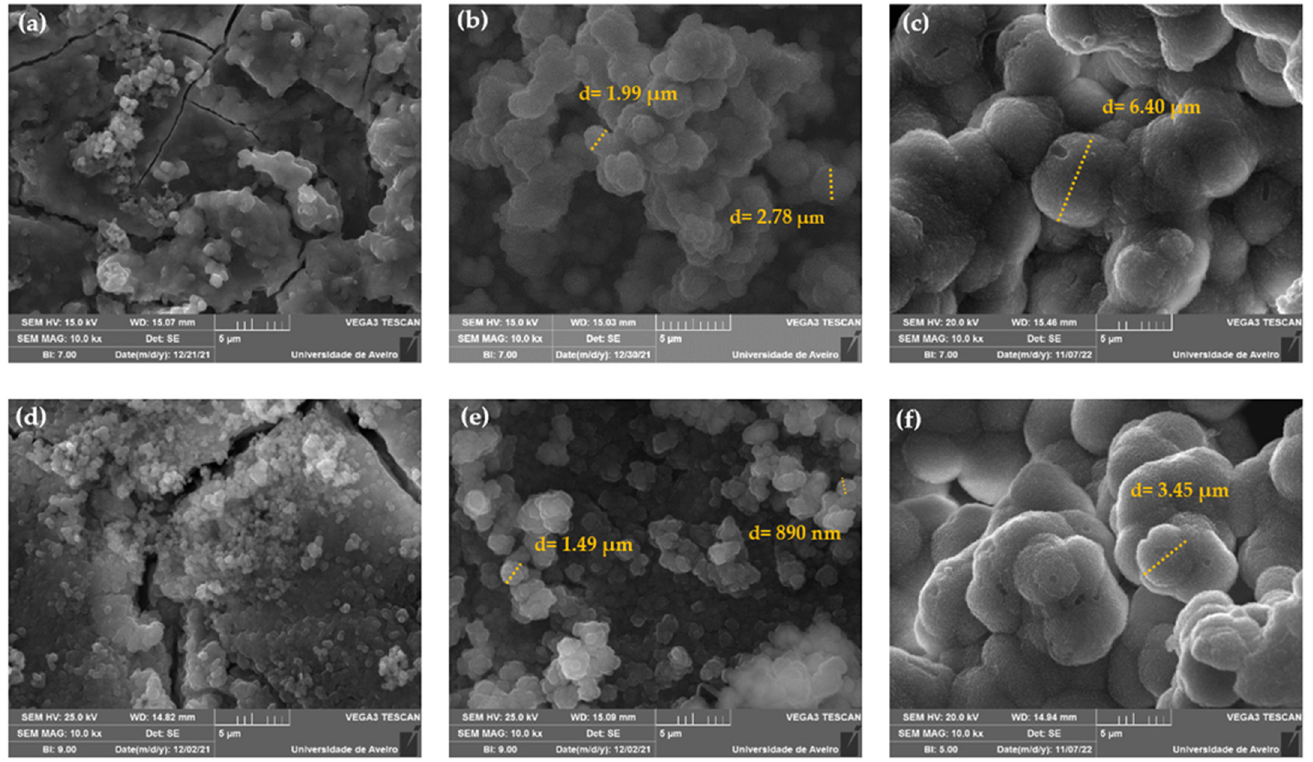
Figure 6. SEM micrographs taken with a magnification of 10 kX of the bioactive glass pellets after 24 h, 96 h and 672 h of immersion in SBF: ( a ) Base 24 h, ( b ) Base 96 h, ( c ) Base 672 h, ( d ) Zn2 24 h, ( e ) Zn2 96 h and ( f ) Zn2 672 h.